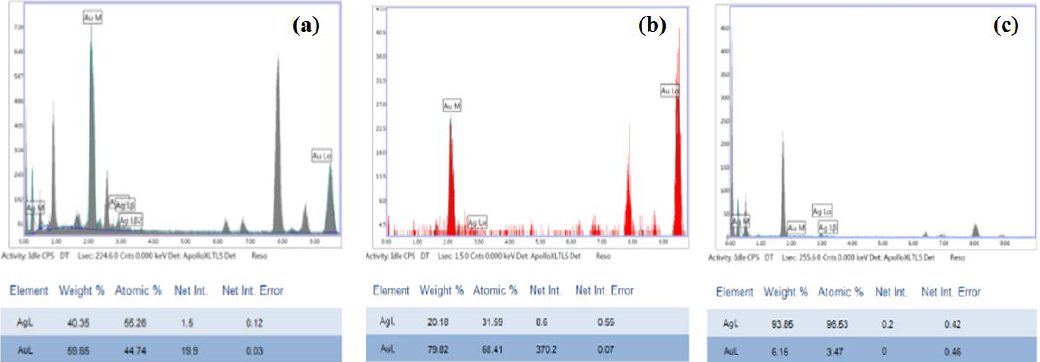
Fig. 4. EDX elemental mapping spectra of (a) Au75:Ag25 (b) Au50:Ag50 and (c) Au25:Ag 75